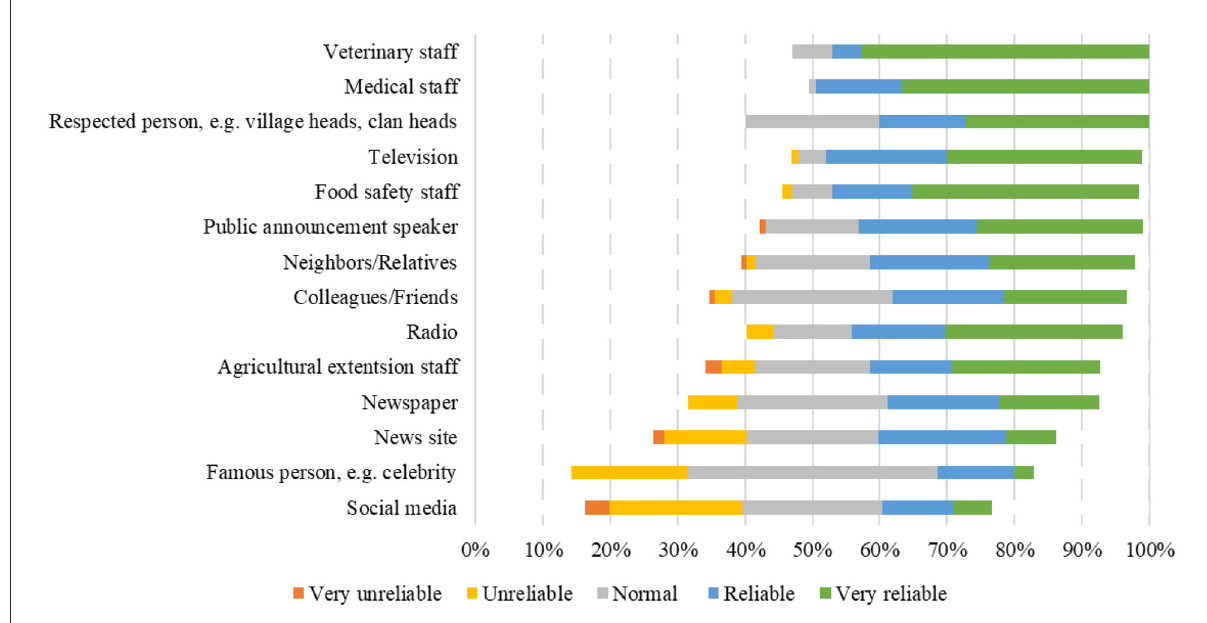
FIGURE5 Trust among pork consumers of different information sources in relation to food safety information in Northern Vietnam in 2019 ( n =